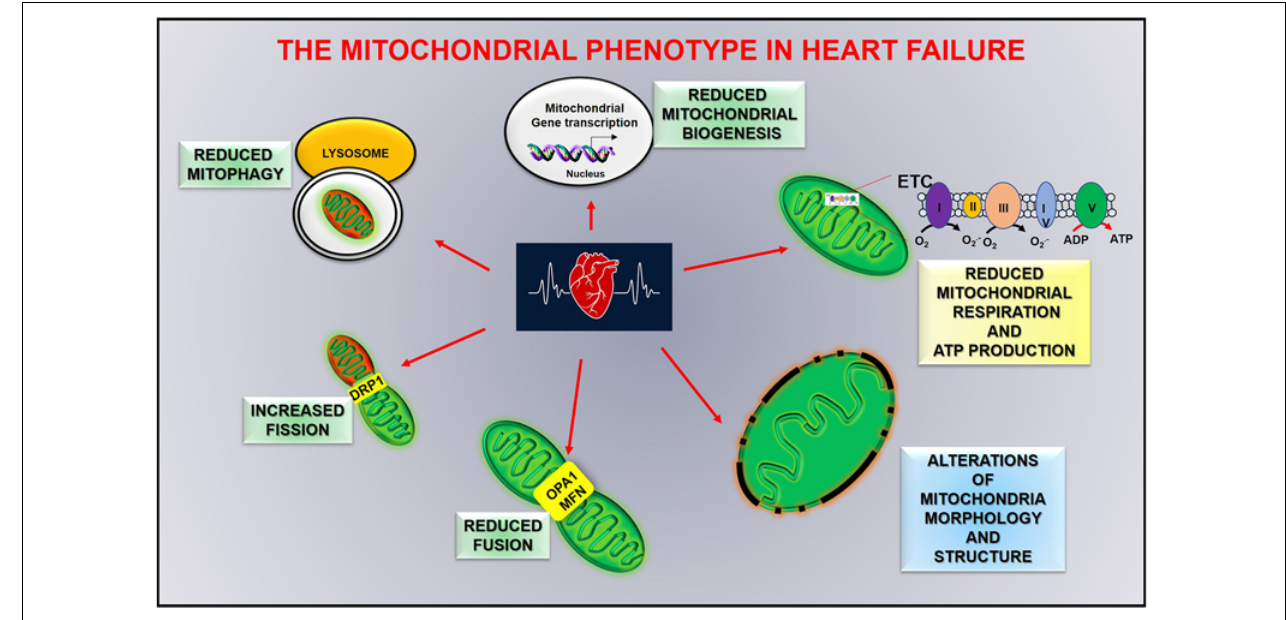
FIGURE 4 | Mitochondrial alterations in heart failure.